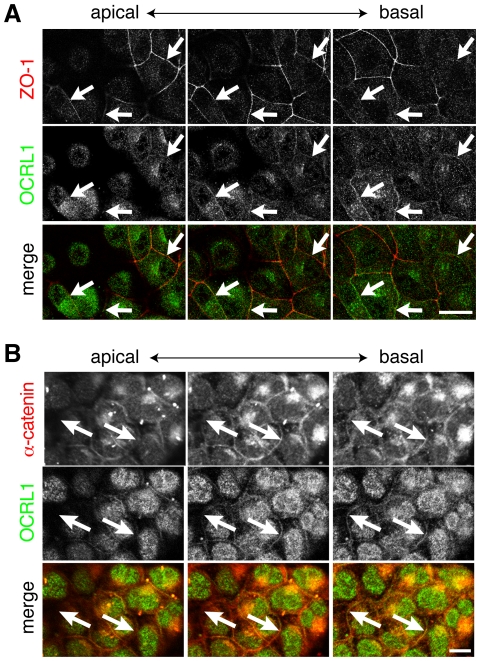
OCRL1 localization is similar to α-catenin, slightly basal to ZO-1.(A) OCRL1 and ZO-1 in MDCK cells, as in Figure 1B, showing multiple confocal sections for a single group of MDCK cells. Arrows indicate the same three sites in all images, where junctional ZO-1 is observed in the apical and middle section, but not the basal section, while OCRL1 is observed more strongly in the basal section than the other two. (B) OCRL1 and α-catenin (red in the merge) in MDCK cells, as in (A). Arrows show a typical junction where staining for both OCRL1 and α-catenin is maximal in the basal section. Scale bars are 10 µm.